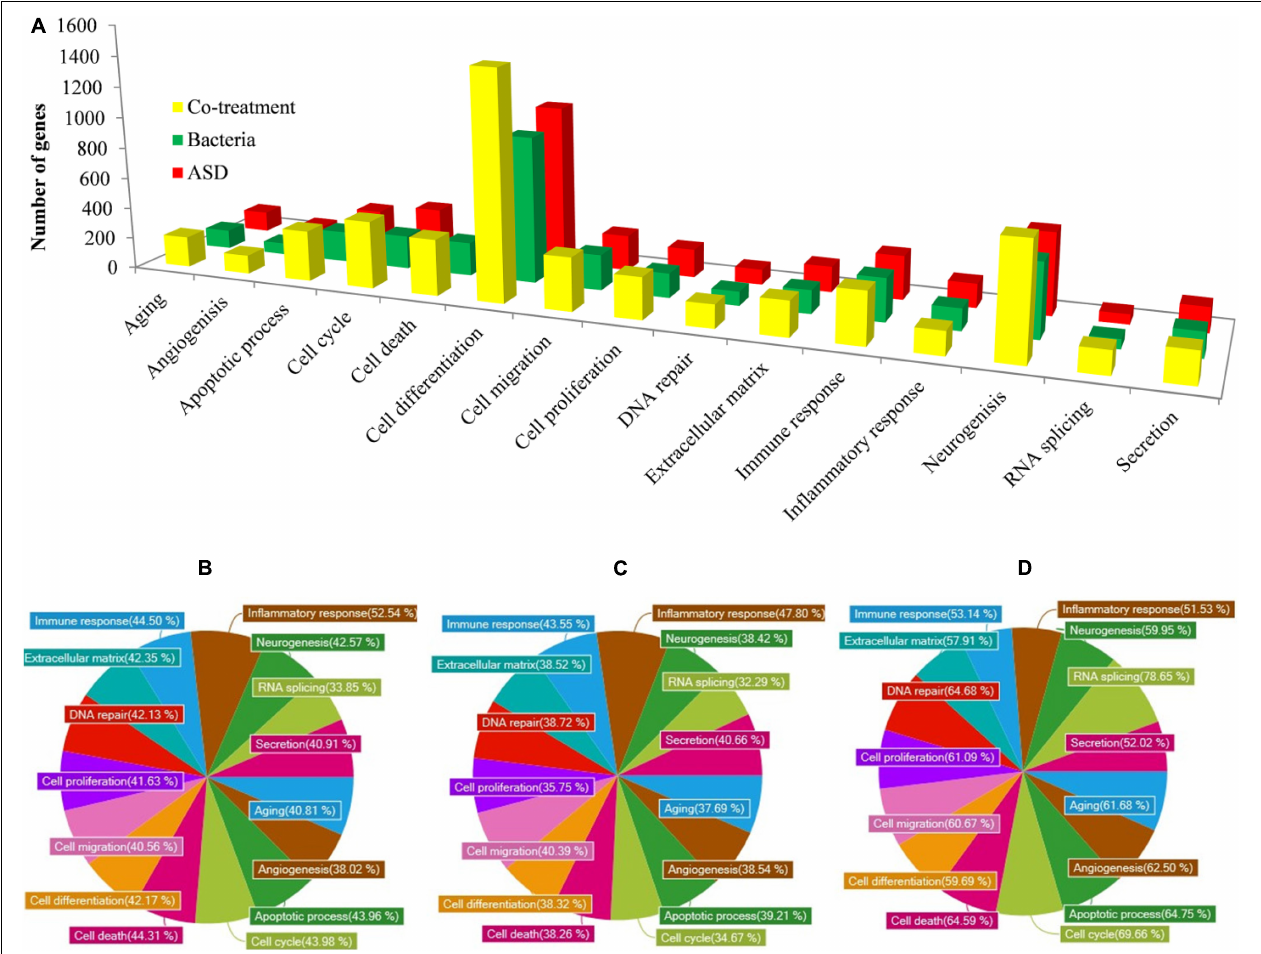
FIGURE 10 | GO (Biological term) of genes differentially expressed in rat middle ear mucosa treated with ASD or Streptococcus pneumoniae or co-treatment with respect to control (untreated). (A) Number of gene and functional categories. (B) Percentage of significantly differentially expressed genes involved in different functional categories and up-regulated or down-regulated upon ASD treatment, (B) S. pneumoniae treatment, or (C)